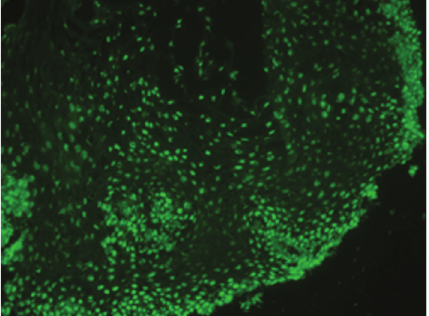
Figure 2: Esophageal tissue stained for